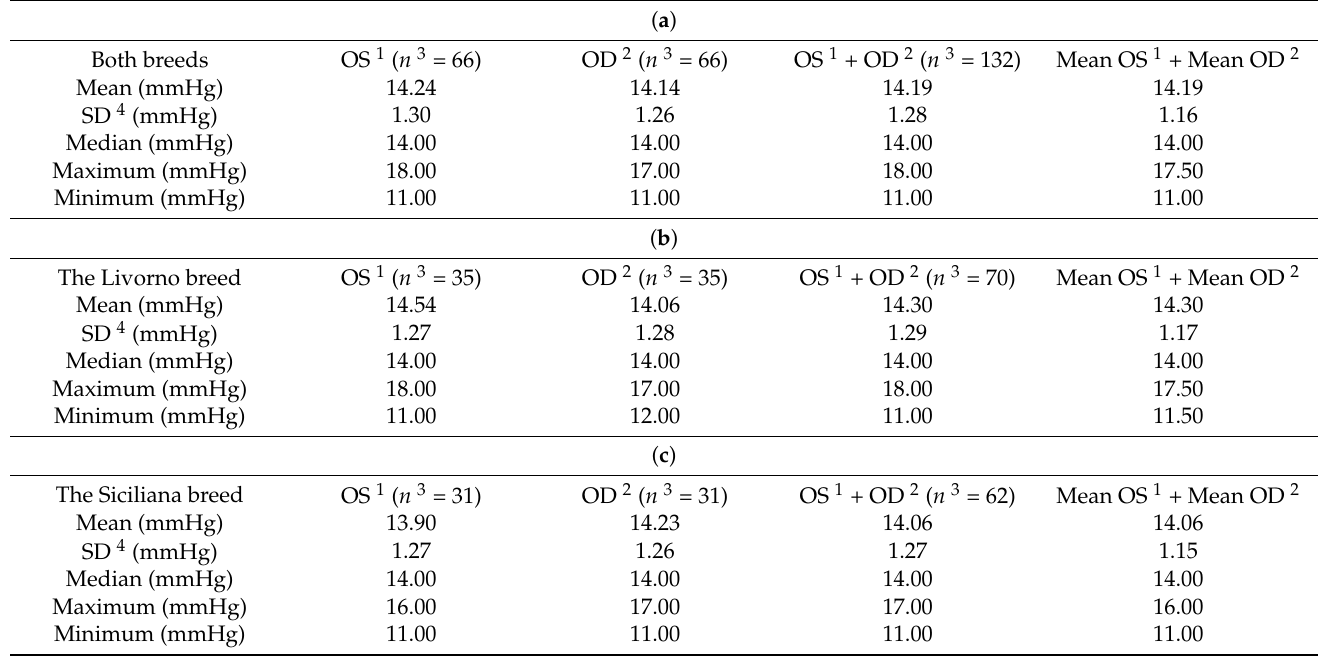
Table 2. ( a ) Descriptive and inferential statistics of IOP data in both breeds; ( b ) descriptive and inferential statistics of IOP data in the Livorno breed; ( c ) descriptive and inferential statistics of IOP data in the Siciliana breed. ( a